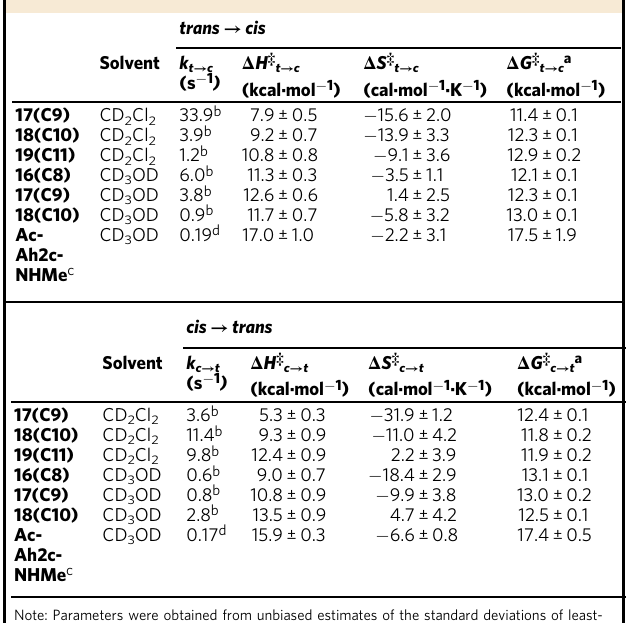
Table 2 Rate constants and activation parameters for amide